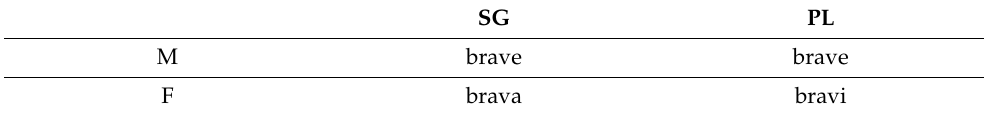
Table 5. Paradigm of adjectives of the first class, e.g., brave “good”. SG PL M brave brave F brava